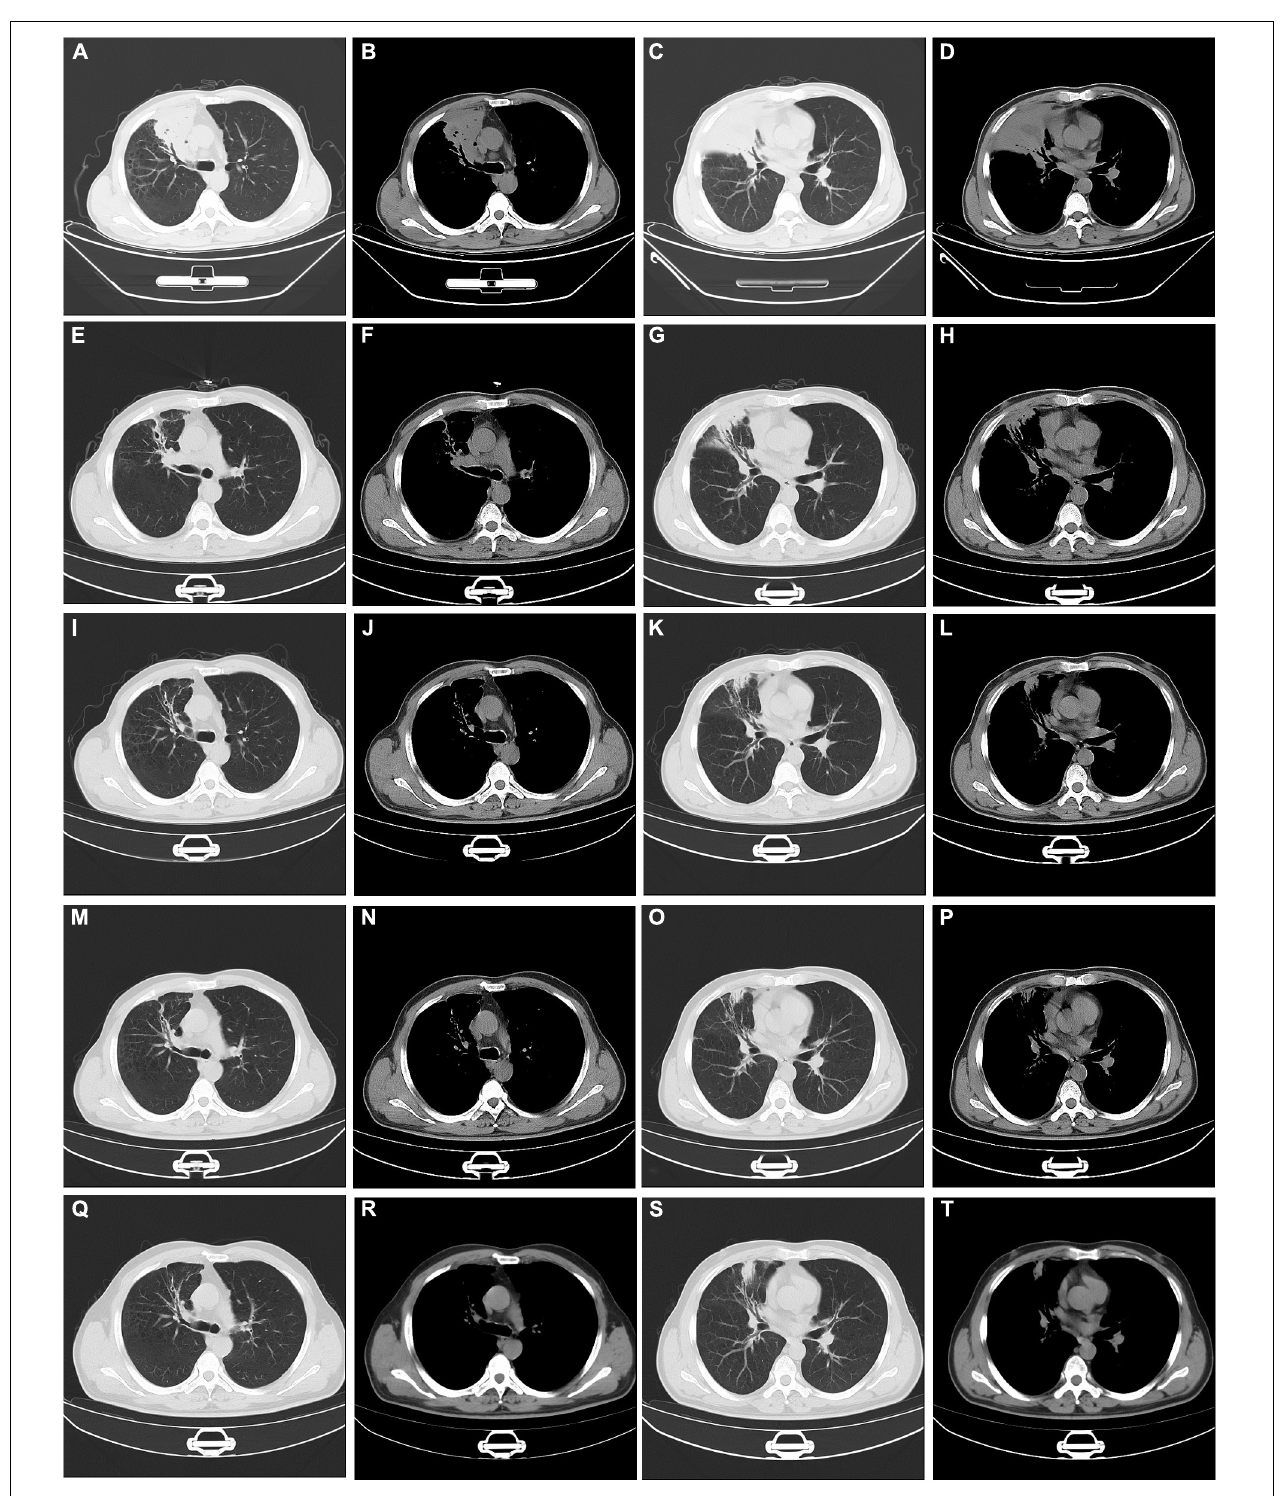
FIGURE 4 | Serial changes on chest computed tomography findings. Chest CT at discharge (A–D) . Chest CT at one month’s follow-up (E–H) . Chest CT at three months’ follow-up (I–L) . Chest CT at five months’ follow-up (M–P) . Chest CT at seven months’ follow-up (Q–T) . CT: computed tomography.